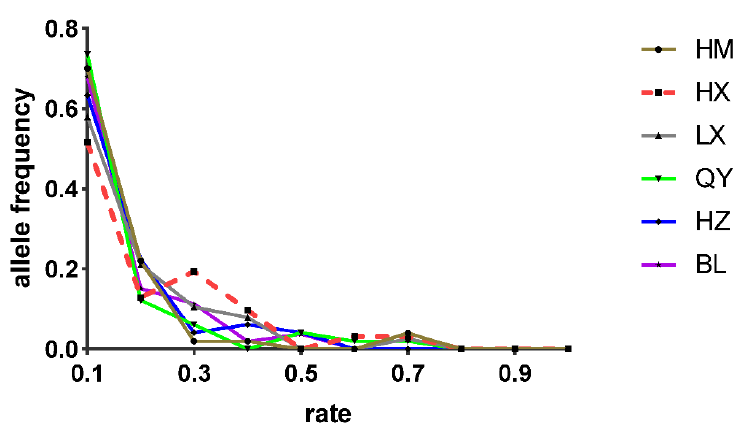
Figure 7. Allele frequency distribution graph of the six populations based on microsatellite markers. A mode shift can be seen in an upstream population (HX), while other populations followed a normal L-shape graph.